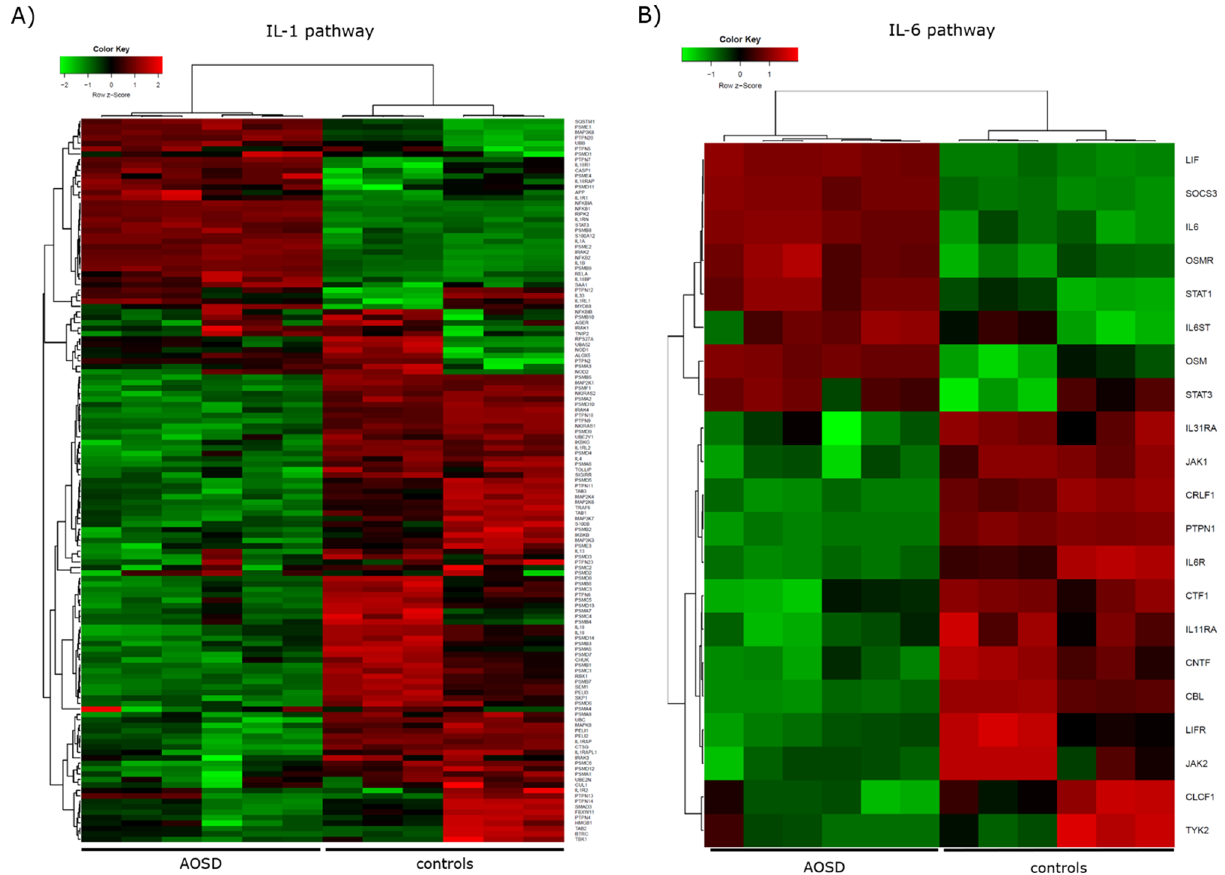
Figure 4. Clustered heatmaps of IL-1 ( A ) and IL-6 ( B ) pathways (R package version 1.0.0, https:// CRAN.R- proje ct. org/ packa ge= ggplot. multi